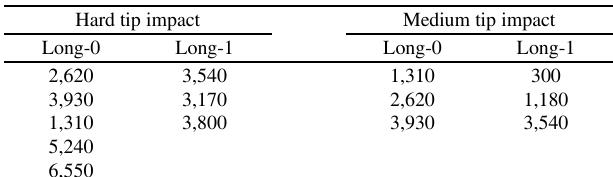
Table 7 Excitation frequencies (Hz) observed in FFT response of acceleration results obtained from the experimental simulation of the long structures. Frequencies are given in descending order of their magnitude